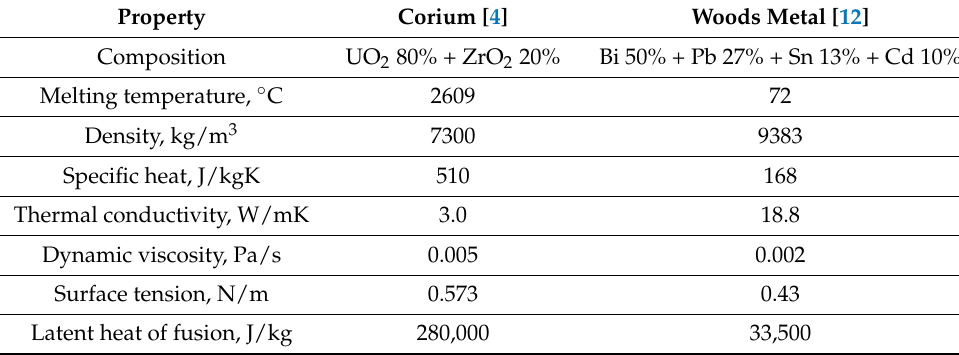
Table 1. Physical property of corium and Woods metal [13].